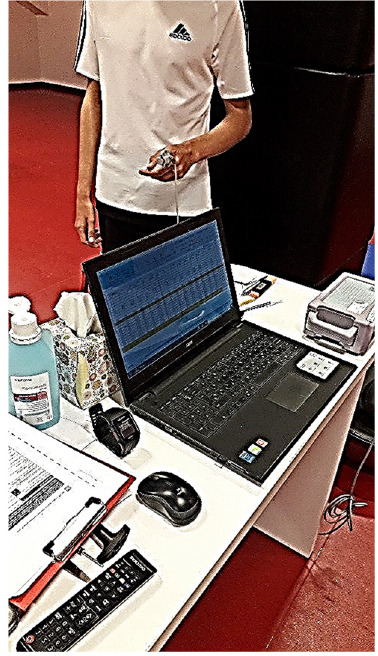
Figure 6. Heart rate measurement device.